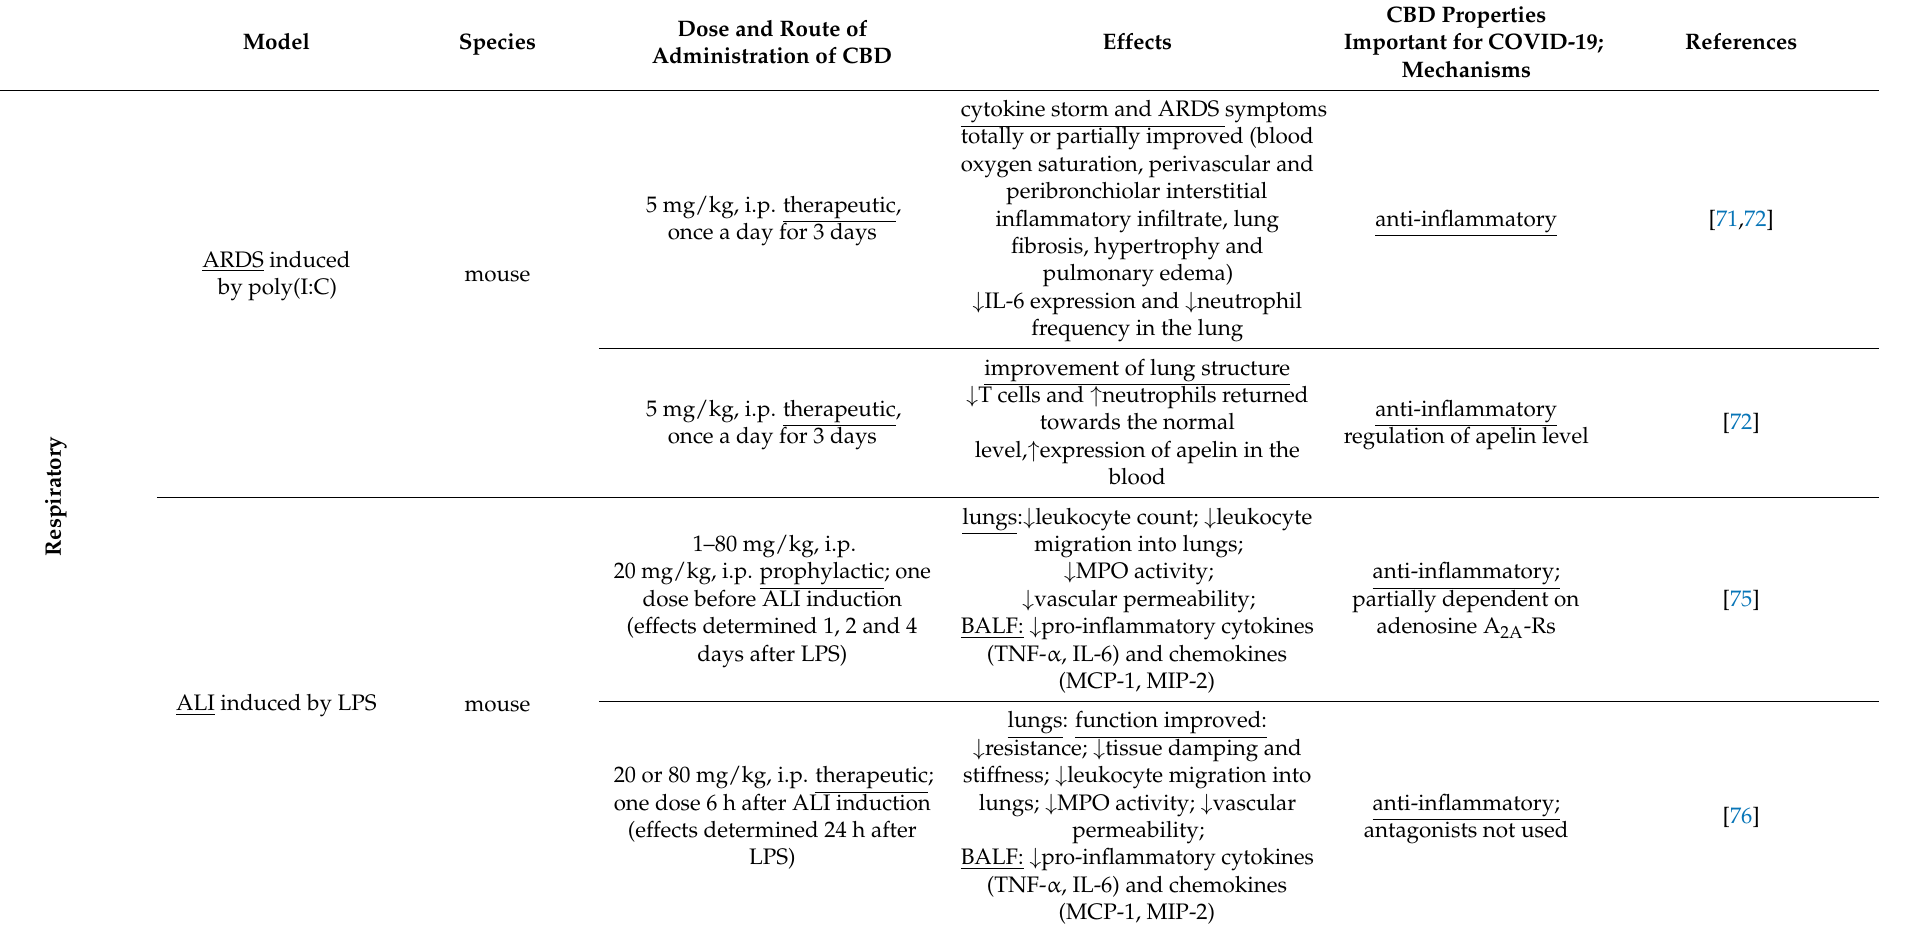
Table 1. Potential use of cannabidiol (CBD) for COVID-19 treatment as suggested by preclinical